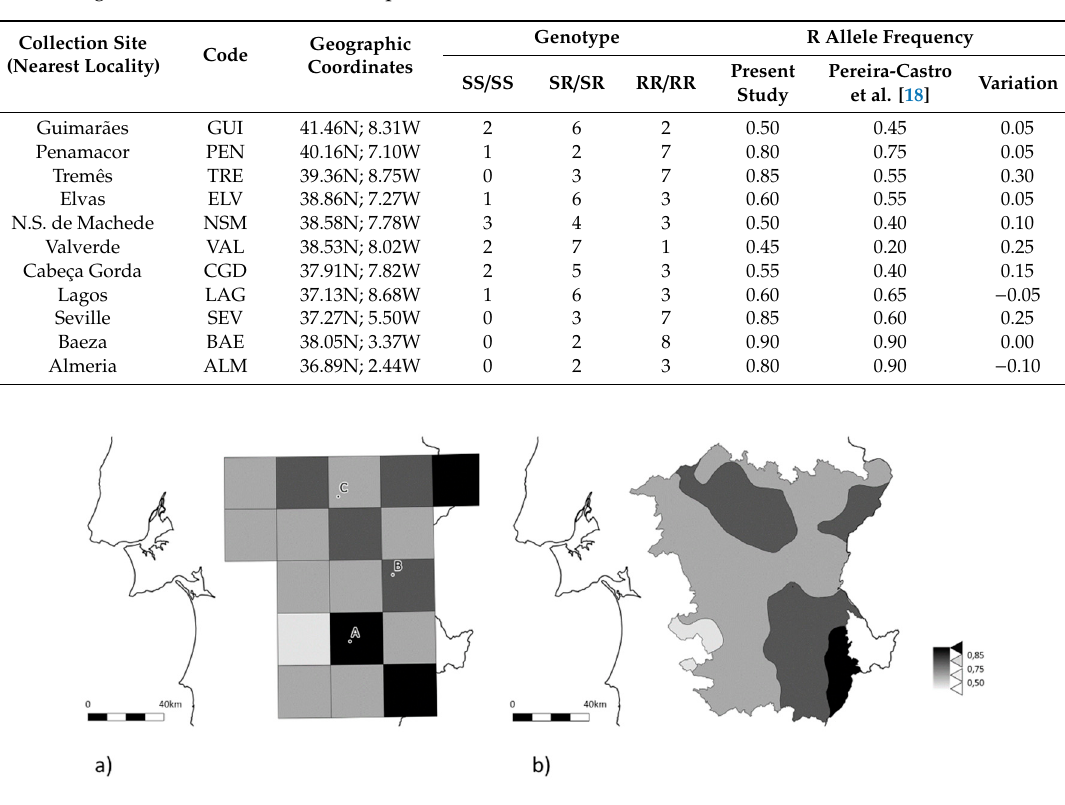
Figure 2. Schematic representation of OP resistance-associated alleles in the olive fruit fly based on 333 samples spread through 71 locations (see Figure 1b for details). ( a ) Observed frequencies by grid square; ( b ) Kriging estimated Alentejo region surface. The darker the gray, the greater is the proportion of OP resistance-associated alleles. White corresponds to the area with no data.